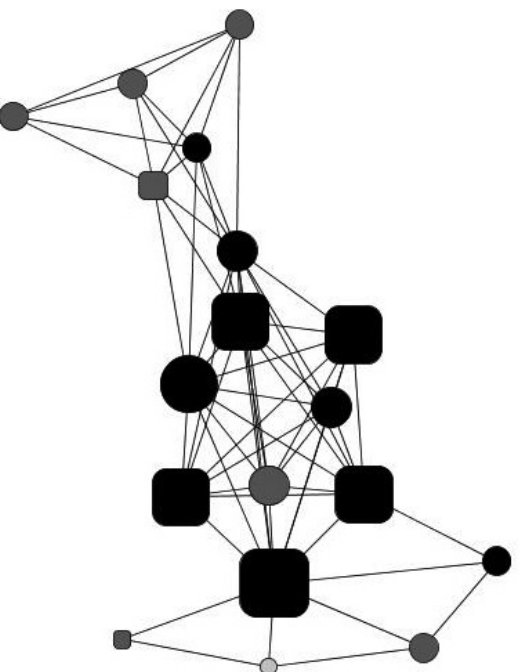
Figure 4. Isabel’s personal network. Notes: Node size indicates relational role—size 1 (biggest; closest family: parents, brothers/sisters, and sons/daughters), size 2 (in‐laws), size 3 (friends, neighbours), size 4 (distant relatives), size 5 (small‐ est; social worker, “others”); node shape indicates gender—circle (female), rounded‐square (male); node colour indicates proximity: black (“very close”), dark grey (“close”), light grey (“not very close”), white (“not close at